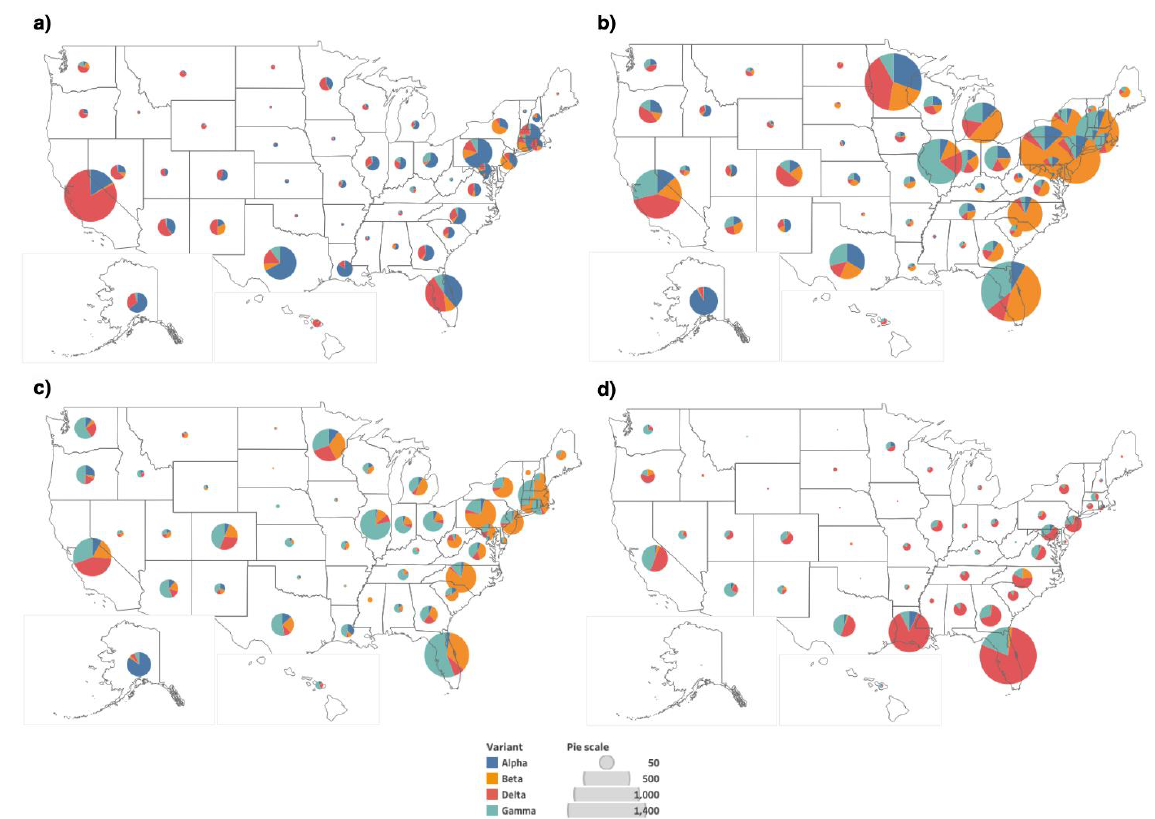
Figure 4. Geographical distribution of the Alpha, Beta, Delta and Gamma variants across the US for four time periods, ( a ) T6, ( b ) T8, ( c ) T9, and ( d ) T11. The legend shows the colors representing the four variants and the pie scale used to size the pies. The pie scale shows count of occurrences, and the pie is sized correspondingly.